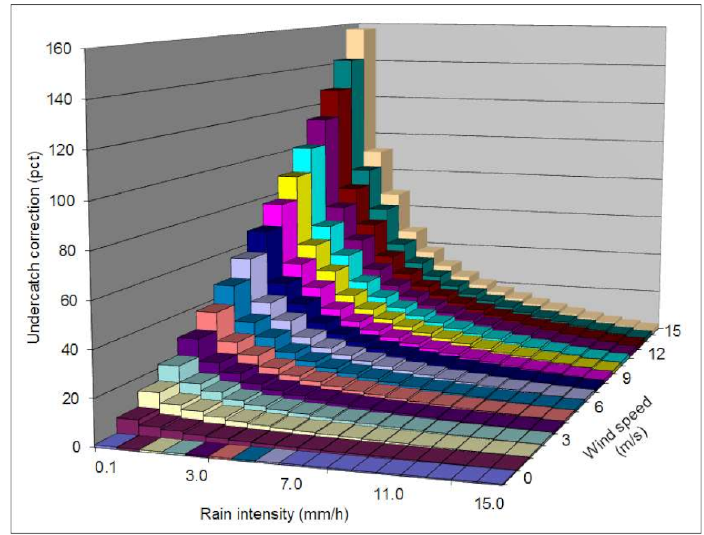
Figure 4. Relationship between wind speed, rain rate, and correction in percentage for rain gauge type